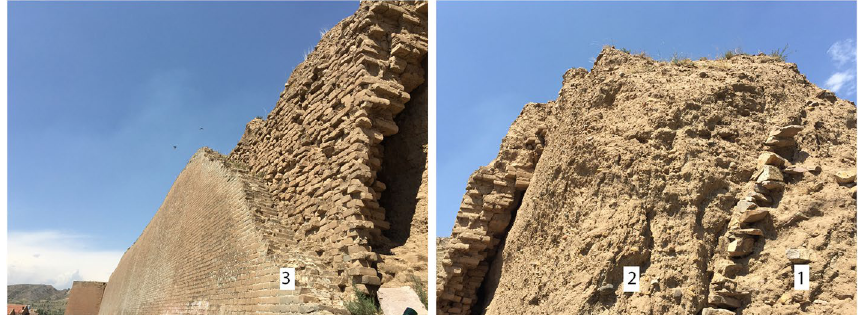
Fig. 7 An expansion of part of the Wall, Zhangjiakou, Hebei Province. Phase 1 (right): earthworks built before the Ming Dynasty from natural stonework without lime binder. Phase 2 (middle): natural stonework renewed at the beginning of the Ming Dynasty. Phase 3 (left): stonework built by the late Ming Dynasty. (Source: Tongji-ACL)